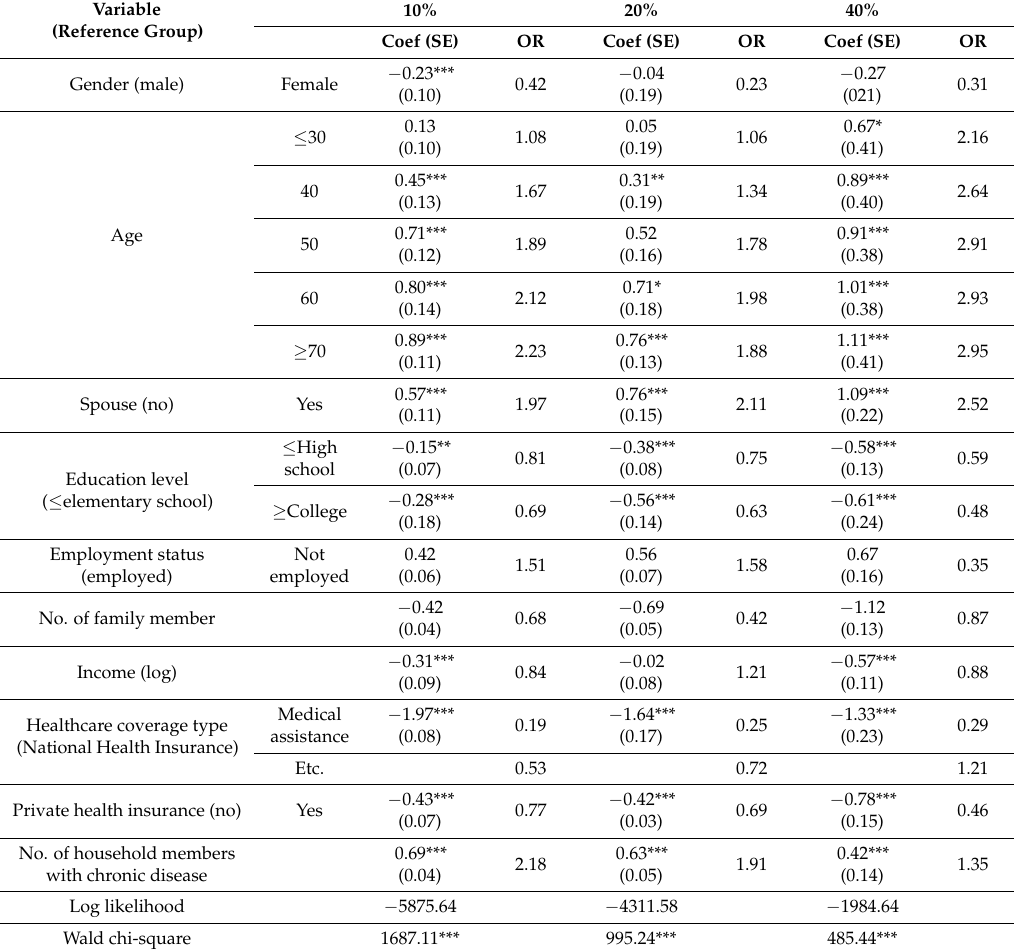
Table 6. Determinants of catastrophic health expenditure of households with cancer